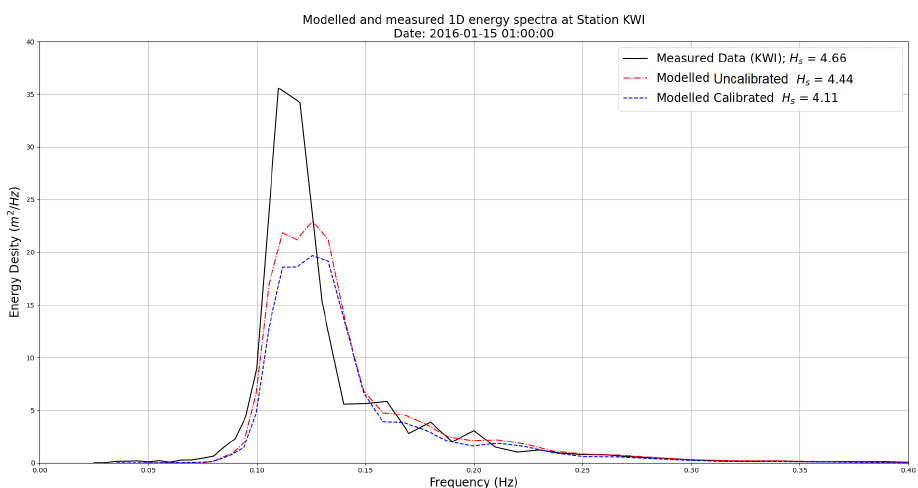
Figure 12. Spectral comparison for the Kwintebank station on 15 January 2016 01:00 showing the uncalibrated and calibrated SWAN models forced with